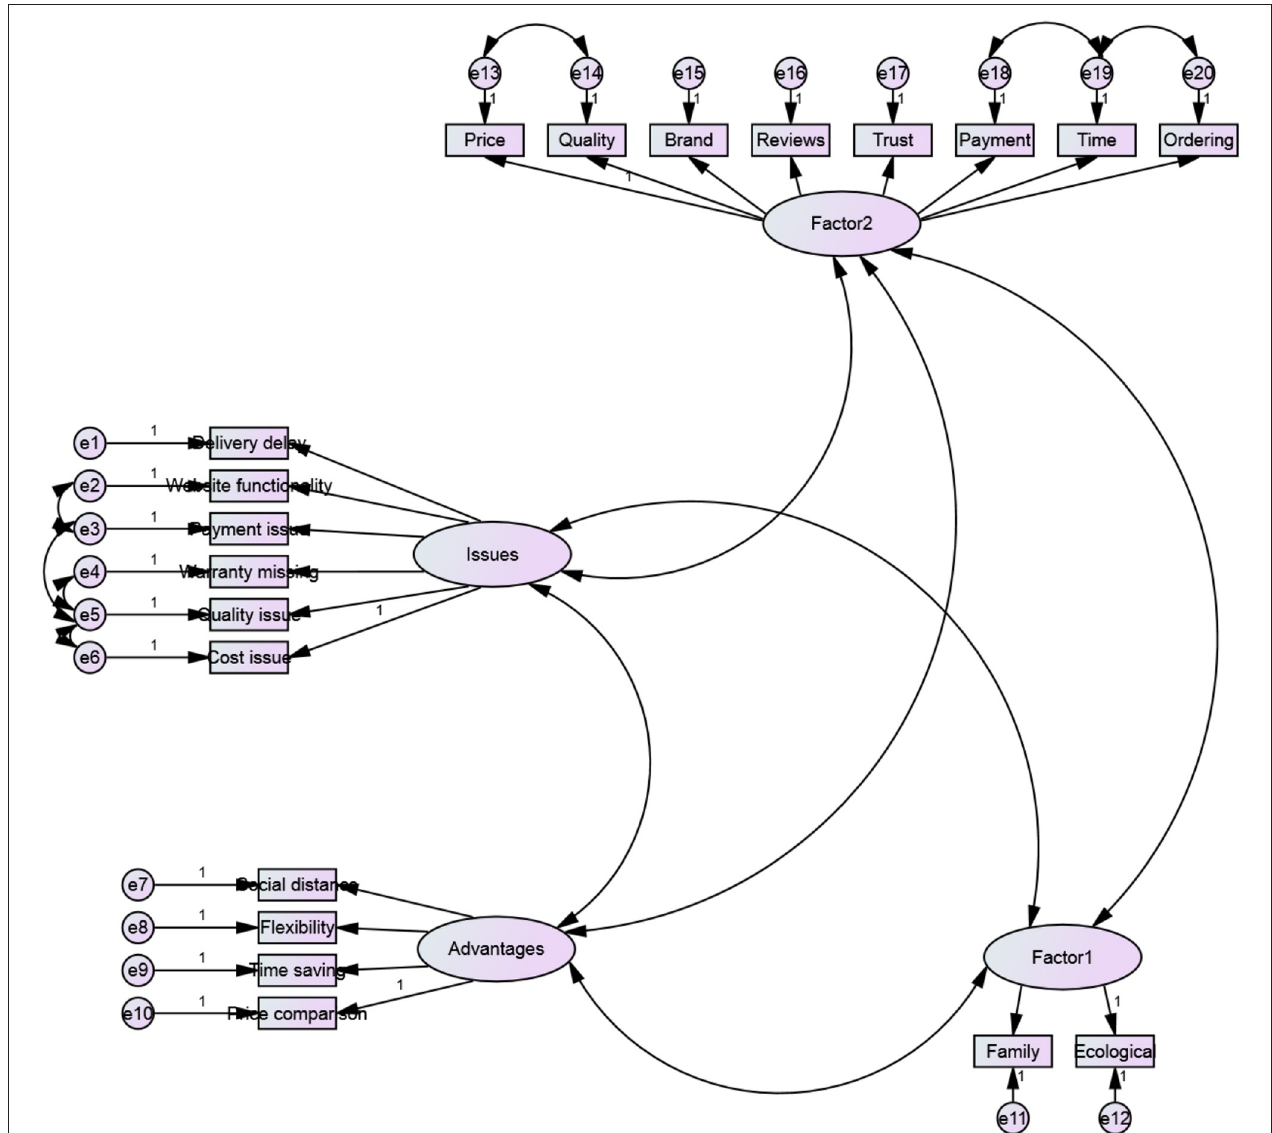
FIGURE 5 | Design of confirmatory factor analysis model. Source: authors’